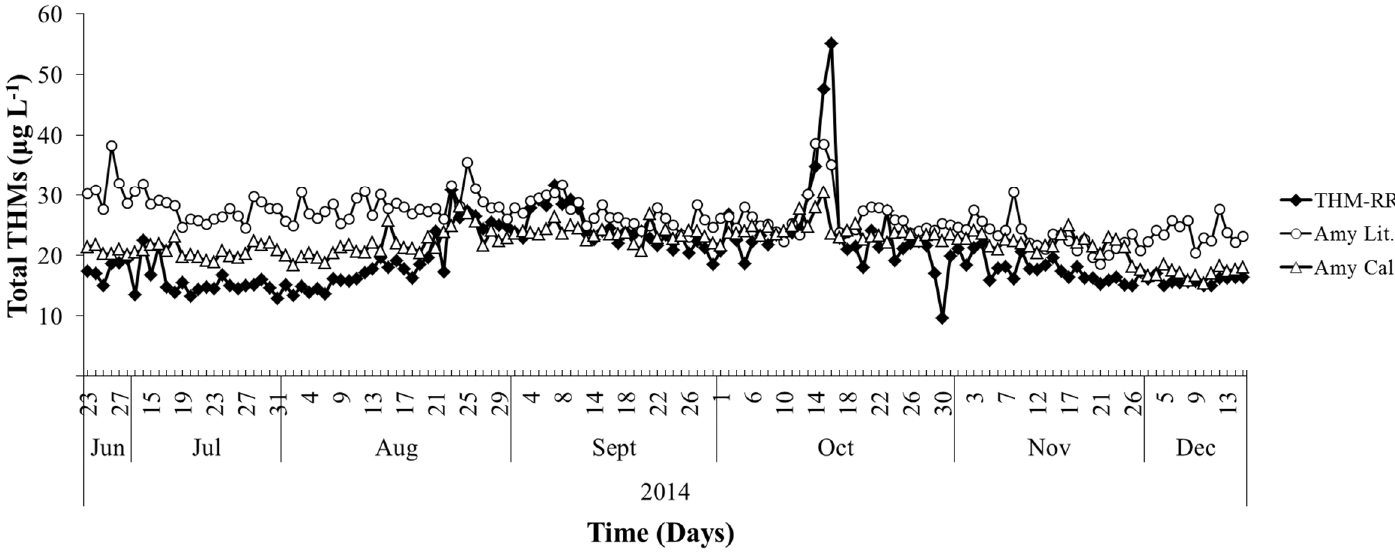
Figure 6. A plot of Total THMs vs. time from 23 June 2014 through 16 December 2014 is shown where predicted Total THMs concentrations using the Amy Literature model (Amy Lit.) and Amy Calibrated model (Amy Cal.) are compared to the Total THMs measurements from the